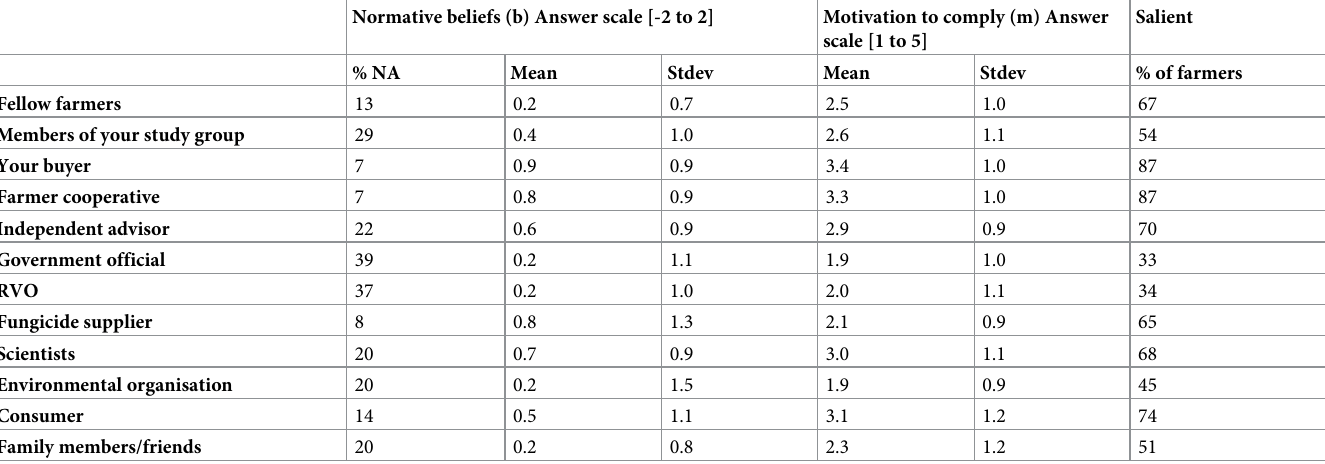
Table 5. Average score social norm (SN) beliefs and the percentage of farmers for which the belief is salient (n = 83). Normative beliefs (b) Answer scale [-2 to